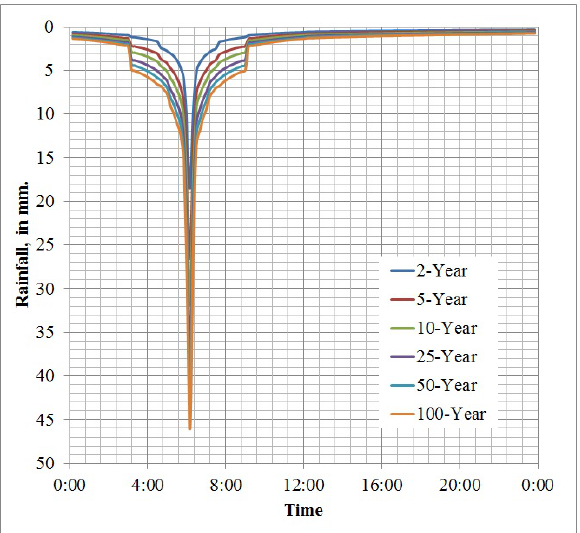
Figure 3: 24-hour rainfall scenario for the 6 hypothetical extreme rainfall events.